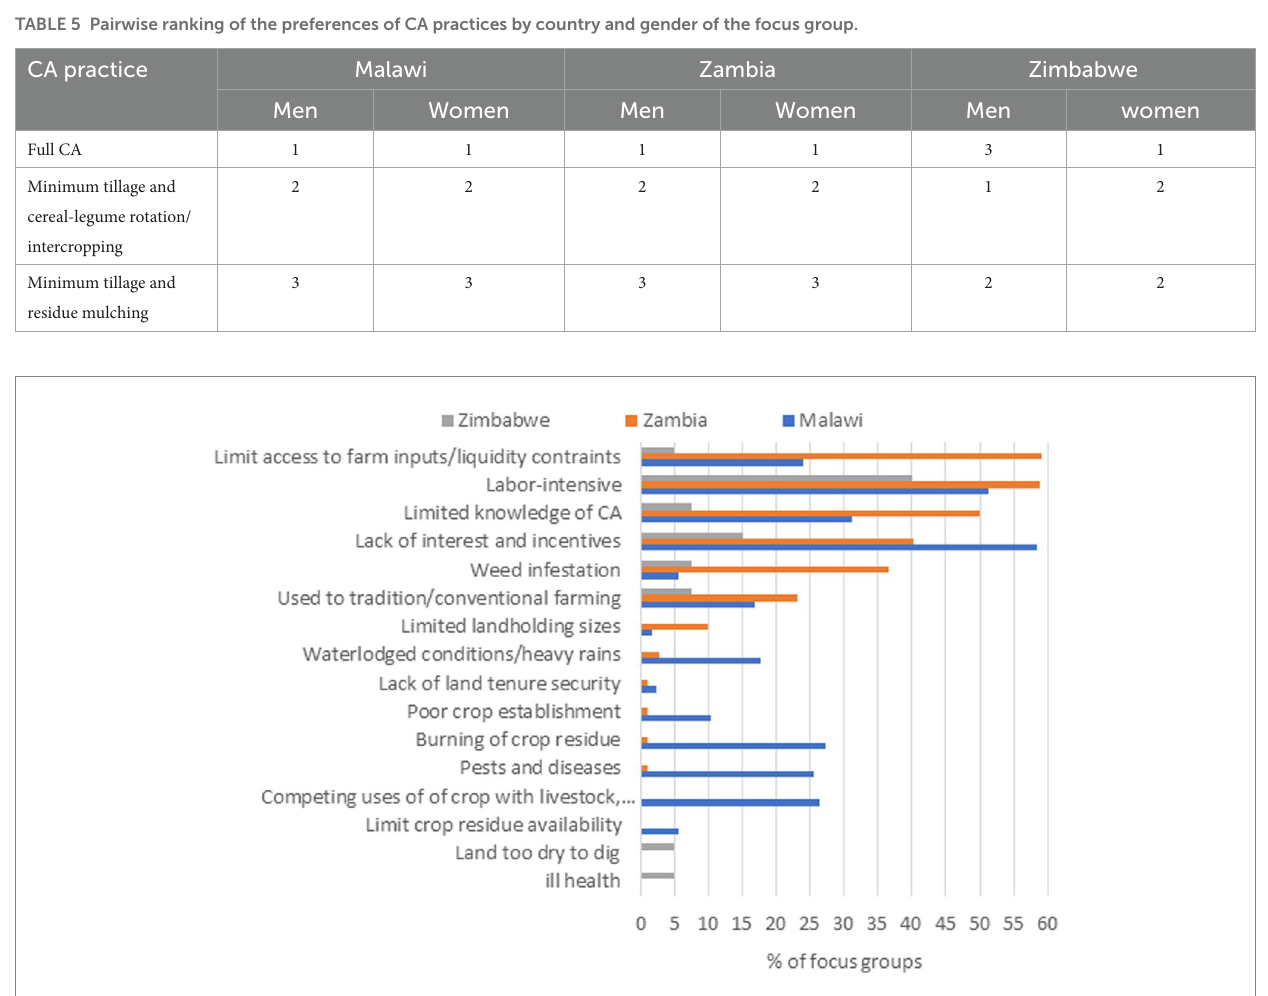
FIGURE 2 Farmers perceptions about barriers to CA adoption (% of focus